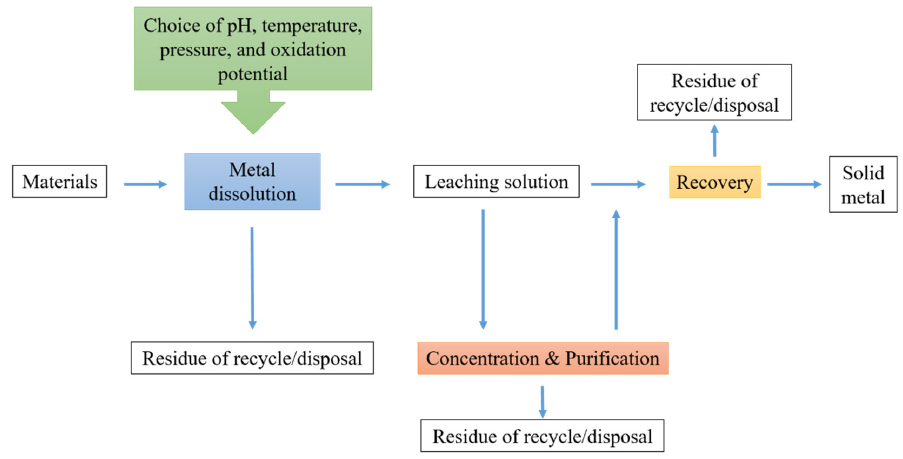
Figure 3. Basic unit process of hydrometallurgical metal extraction (modified from [145]).